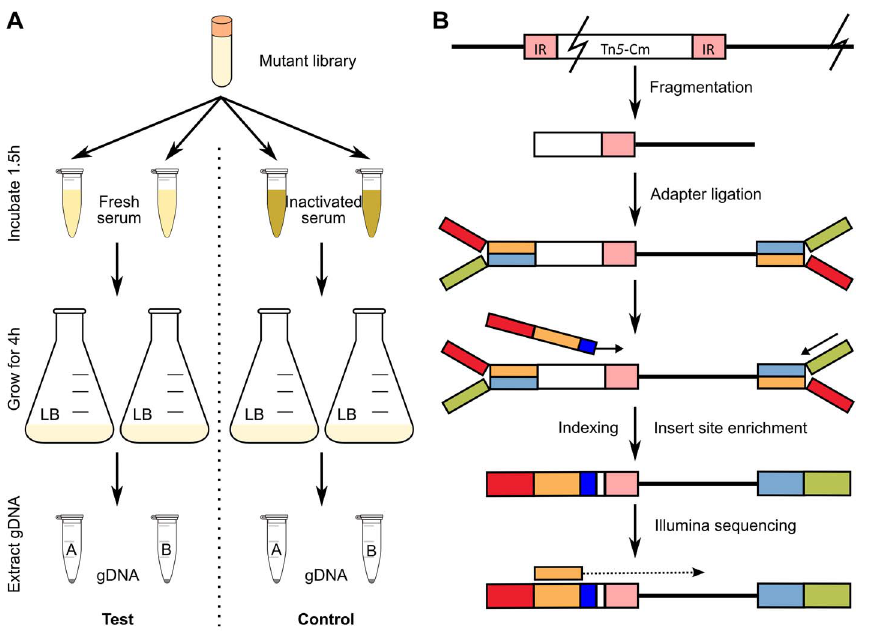
Figure 3. Experimental design to identify serum resistance genes in EC958. (A) Selection steps employed using fresh serum as test and inactivated serum as control. (B) Schematic illustration of the Illumina sequencing procedure including the use of a custom oligo for indexing and enrichment of insert sites.